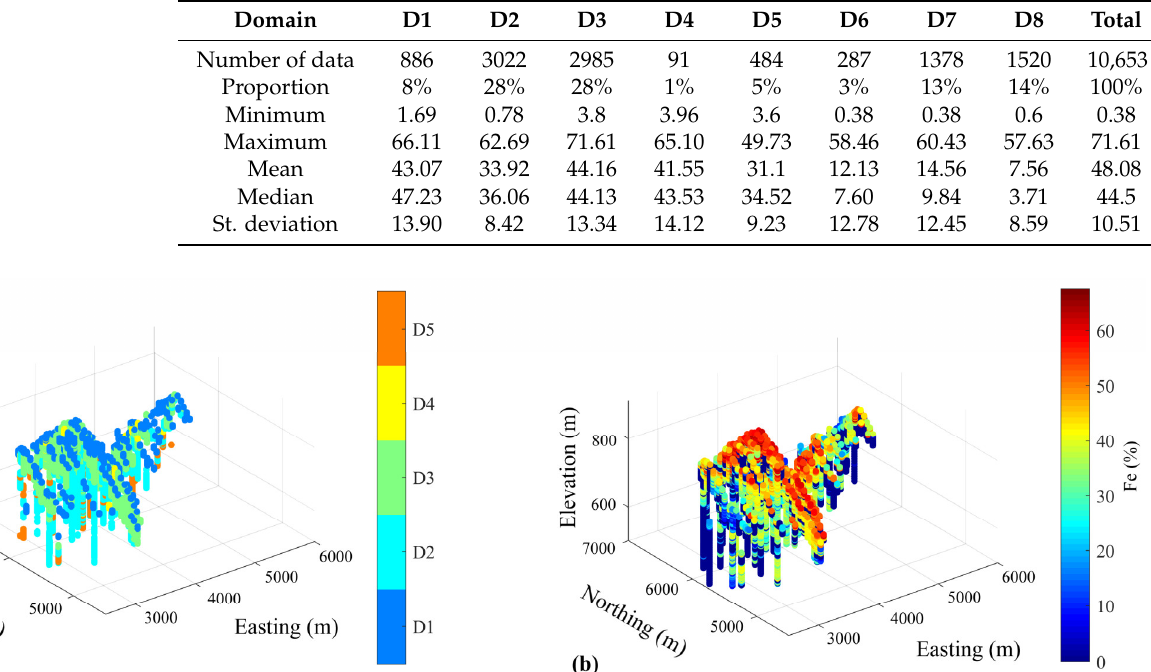
Figure 2. 3D representation (with local coordinates) of ( a ) ore domains (D1 to D5), ( b ) iron grade data in these domains. The waste domains (D6 to D8) are mostly located at depth and are not rep-